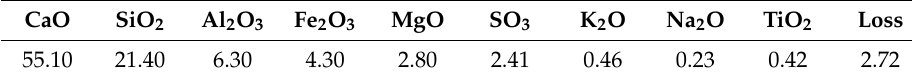
Table 1. Chemical composition of the cement (wt%).